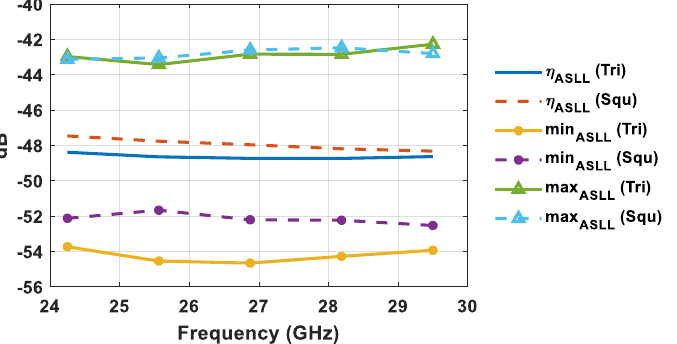
Figure 9. ASLL statistical comparison of square and equilateral triangular lattices by considering the whole visible region.